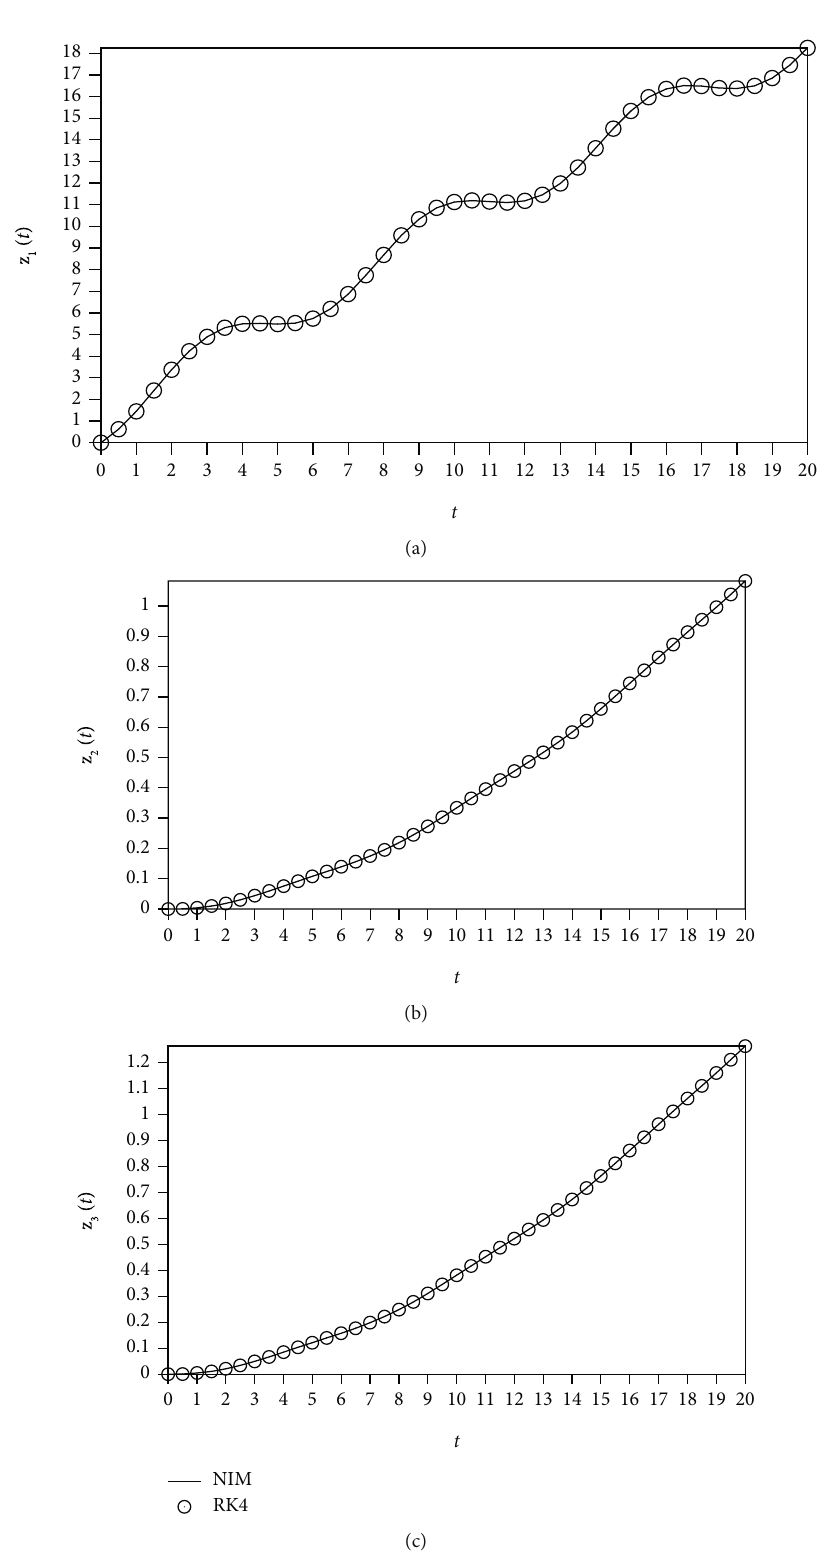
t Þ , (b) z t Þ , and (c) z t Þ in the sinusoidal input 1 ð 2 ð 3 ð